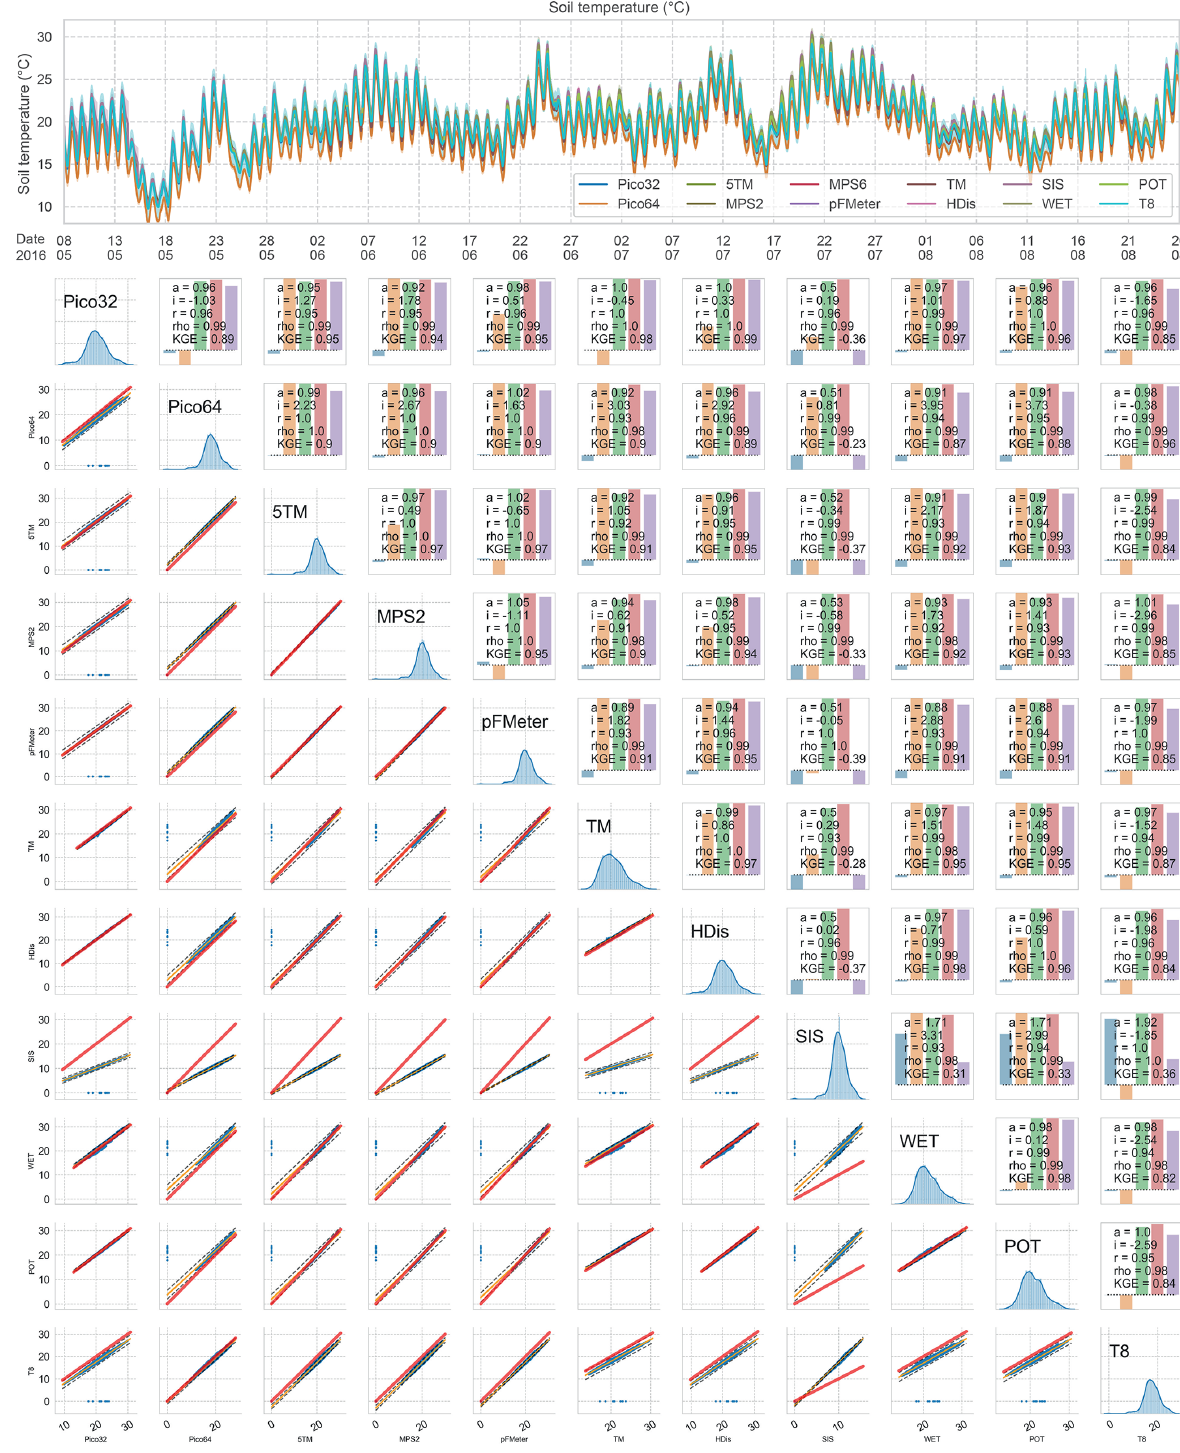
Figure A3. Upper panel: time series of most recorded temperature values. Lower panels: correlation matrix of the sensor systems with temperature recording (given in ◦ C). Diagonal panels give histogram and kernel density distribution of 0.5h means of all sensors of one system. Lower half gives scatter plot (blue dots), linear regression (orange line), 0.95 predictive uncertainty bands (grey dashed lines) and the 1 : 1 line (red). The upper half reports the respective correlation measures, with a and i as scaling factor and intercept of the linear regression model, r as Pearson correlation coefficient, rho as Spearman rank correlation coefficient, and KGE as Kling–Gupta efficiency. These values are plotted as bars in the same order in the background, where a is plotted as deviation from